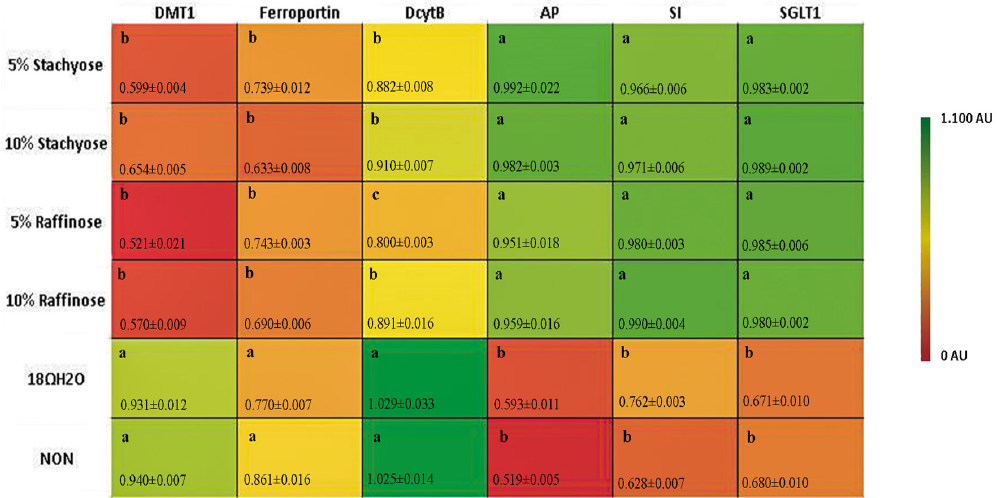
Figure 2. Duodenal mRNA expression (in AU) of measured brush border membrane (BBM) functional and Fe metabolism genes on the day of hatch. Values are means ± SEM, n = 8. Standard errors are represented by vertical bars. Per gene, treatments groups not indicated by the same letter are significantly different ( p < 0.05). AP: aminopeptidase; SI: sucrase isomaltase; SGLT1: sodium glucose cotransporter ‐ 1.